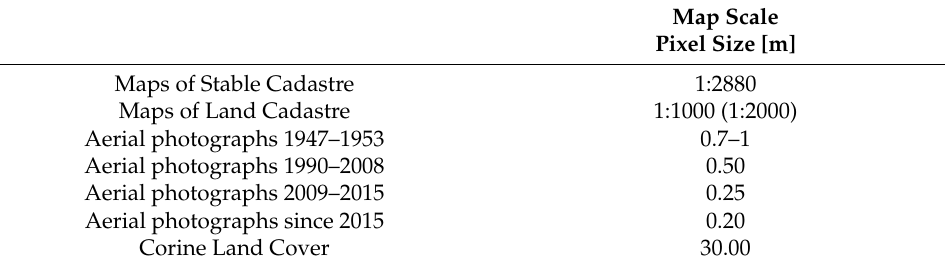
Table 2. The spatial resolution and scales of the used real land use